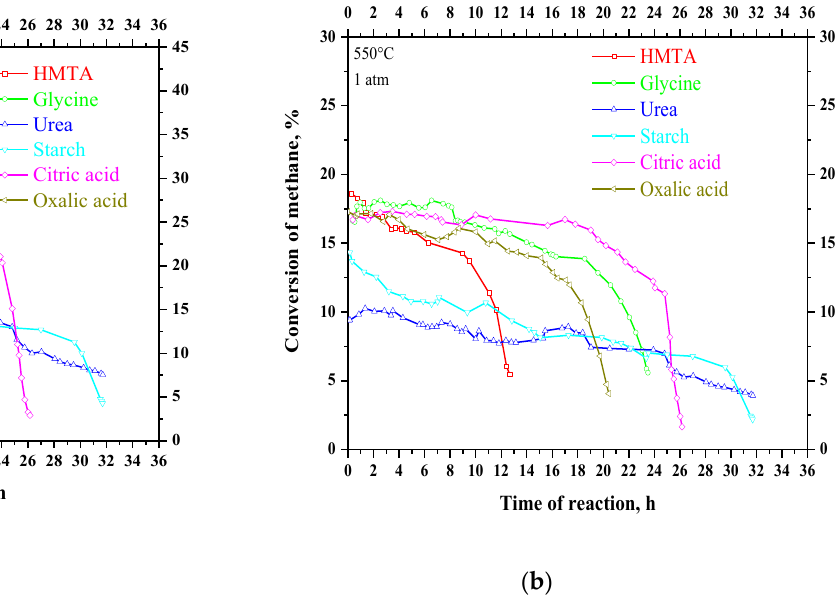
Figure 3. Hydrogen concentration ( a ) and conversion of methane ( b ) vs. time of reaction for catalysts synthesized by SCS using various fuels (450 °C, 1 atm).